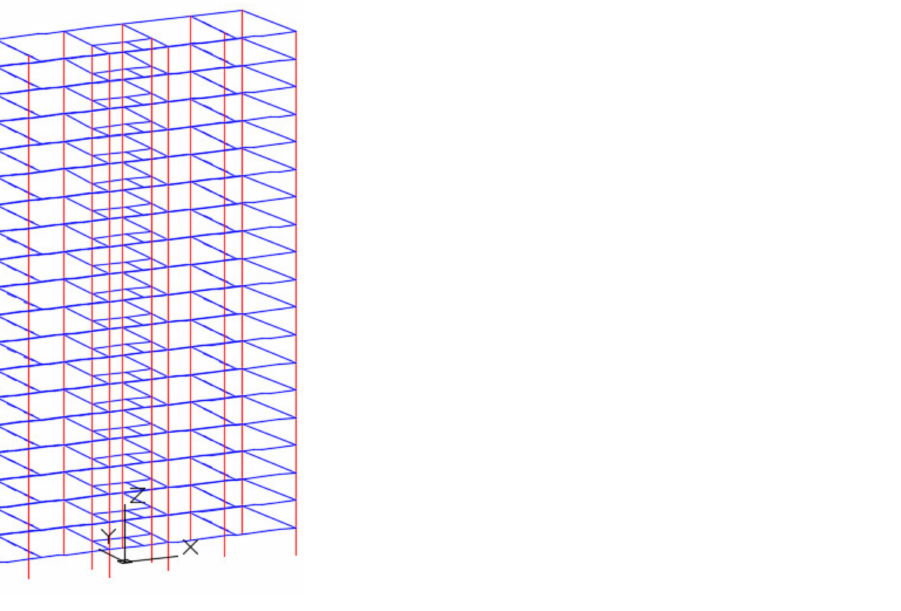
Figure 8. Finite elements mesh with beam elements (in blue) and columns (in red) used to simulate the superstructure of a 19-storey